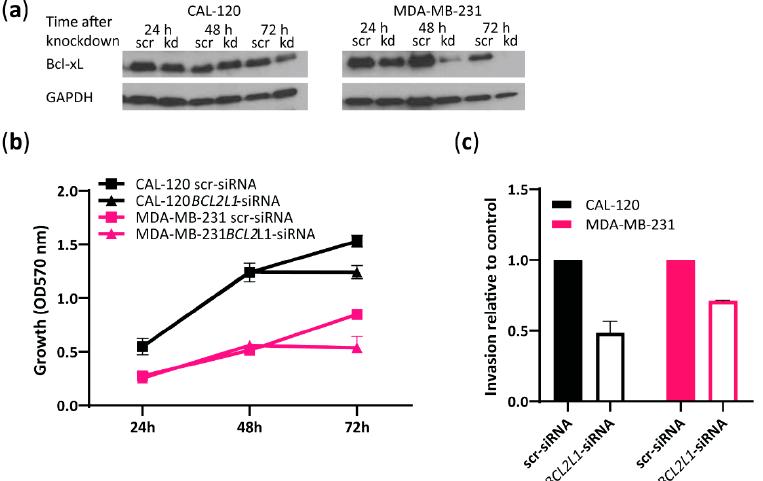
Figure 4. BCL2L1 siRNA-mediated knockdown reduces the invasive properties of basal B TNBC cells. ( a ) Western blot analysis of Bcl-xL in CAL-120 and MDA-MB-231 cells before and after treatment with BCL2L1 –siRNA or scrambled siRNA at 24, 48 and 72 h. GAPDH was used as loading control; ( b ) Evaluation of CAL-120 and MDA-MB-231 cell growth at 24, 48 and 72 h following BCL2L1 siRNA-mediated knockdown determined by crystal violet colorimetric assay; ( c ) Analysis of invasive properties of CAL-120 and MDA-MB-231 cells at 72 h after treatment with BCL2L1 –siRNA relative to cells treated with scrambled siRNA (control). The data represent the mean of two biological replicates ± SEM.